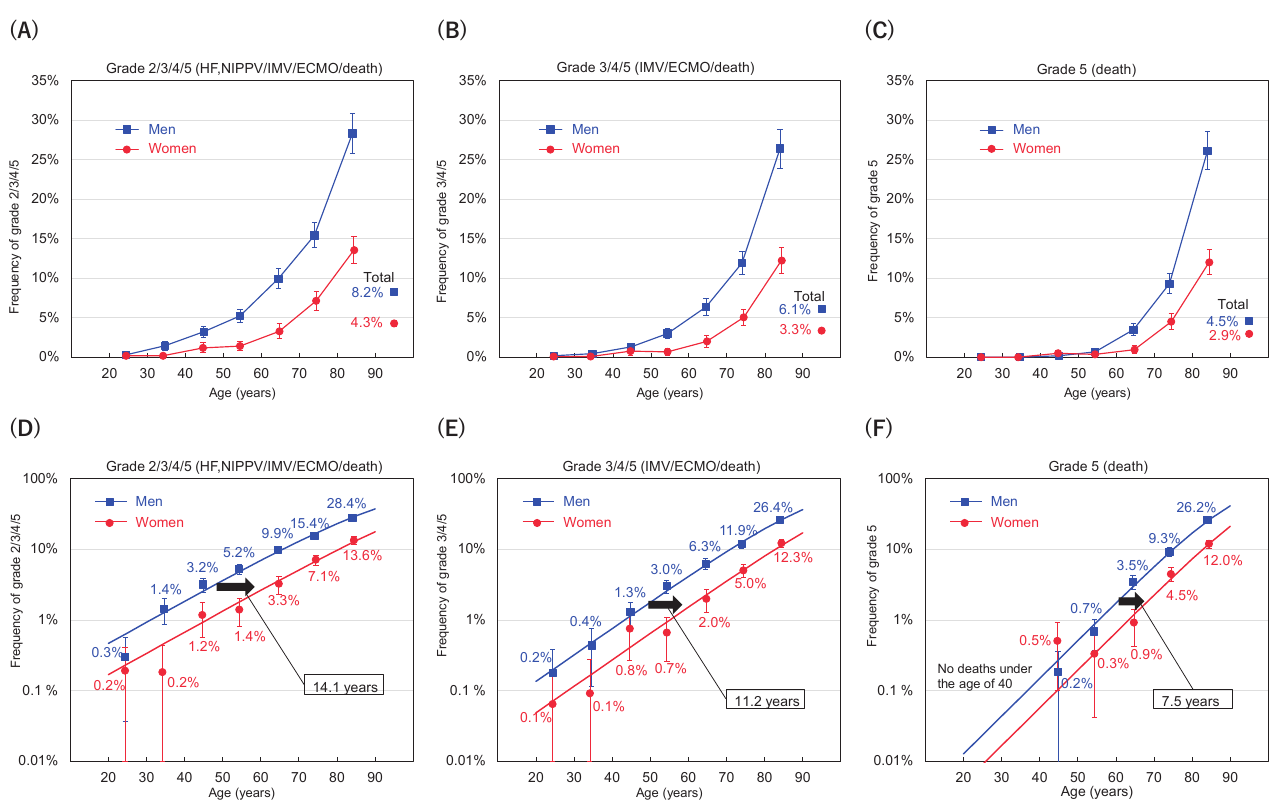
Figure 1. Frequency of severe disease grades according to sex and age groups among COVID-19 patients registered in Japan. The frequency with 95% con fi dence interval is plotted against the mean age of each group ( A , B , and C ). In the lower panel, the same data are plotted on a logarithmic Y-axis scale; the fi tted lines were estimated by logistic regression models ( D , E , and F ). The estimated risks of severity grades 2 / 3 / 4 / 5, 3 / 4 / 5 and 5 for men were equivalent to those of women 14.1, 11.2, and 7.5 years older, respectively, after adjustment for the date of hospital admission. ECMO, extracorporeal membrane oxygenation; HF, high- fl ow oxygen devices; IMV, invasive mechanical ventilation; NIPPV, non-invasive positive pressure